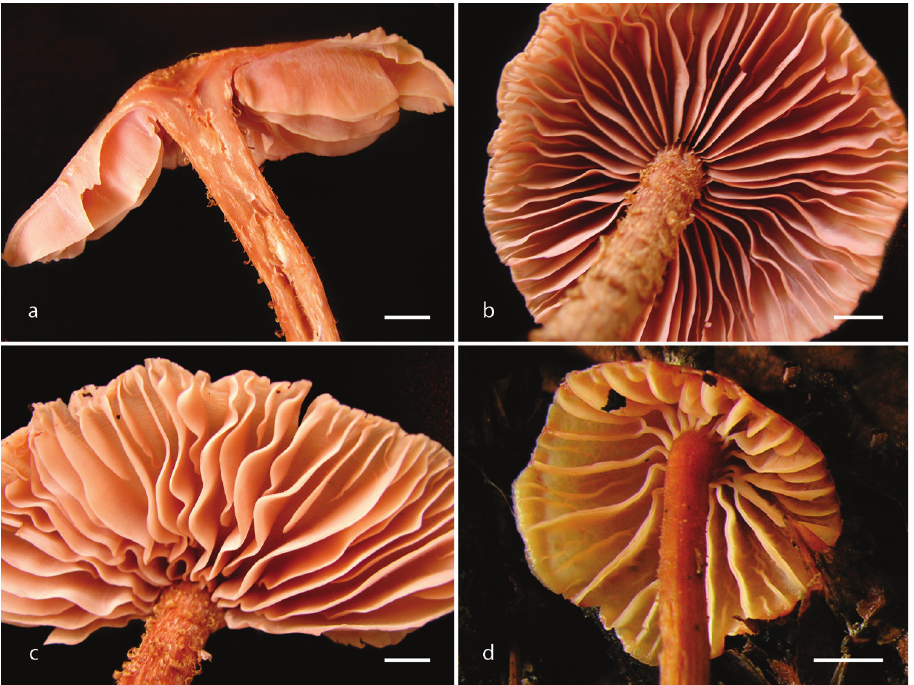
Figure 3. Laccaria squarrosa , lamellae attachment and habit. a, c DM 121 b DM 63 (holotype) d DM 93. Scale bars: 10